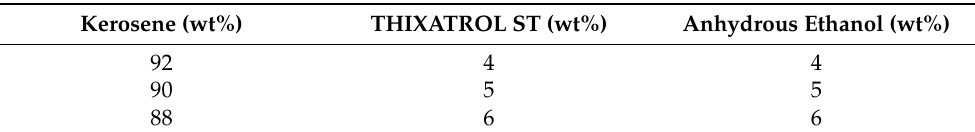
Table 3. The components of organic kerosene gel.